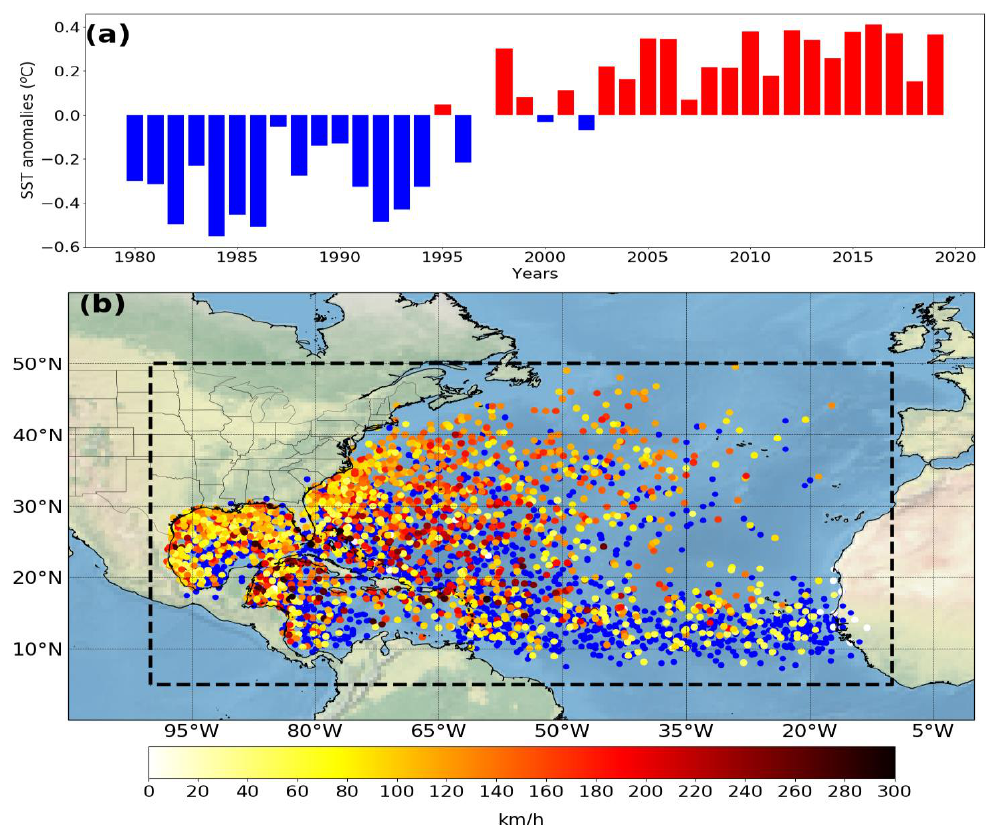
Figure 1. ( a ) Centennial Time Scale (COBE) sea surface temperature (SST) anomalies time-series; ( b ) location of the genesis (blue points) and peak of maximum intensity (the color bar represents the maximum surface wind) of (tropical cyclones TCs) formed in the North Atlantic (NATL) basin. The genesis point is defined as the first reported location in the Atlantic hurricane database ( HURDAT2) database. The black dashed line represents the interest area for the SST analysis. Period: June–November from 1980 to 2019.